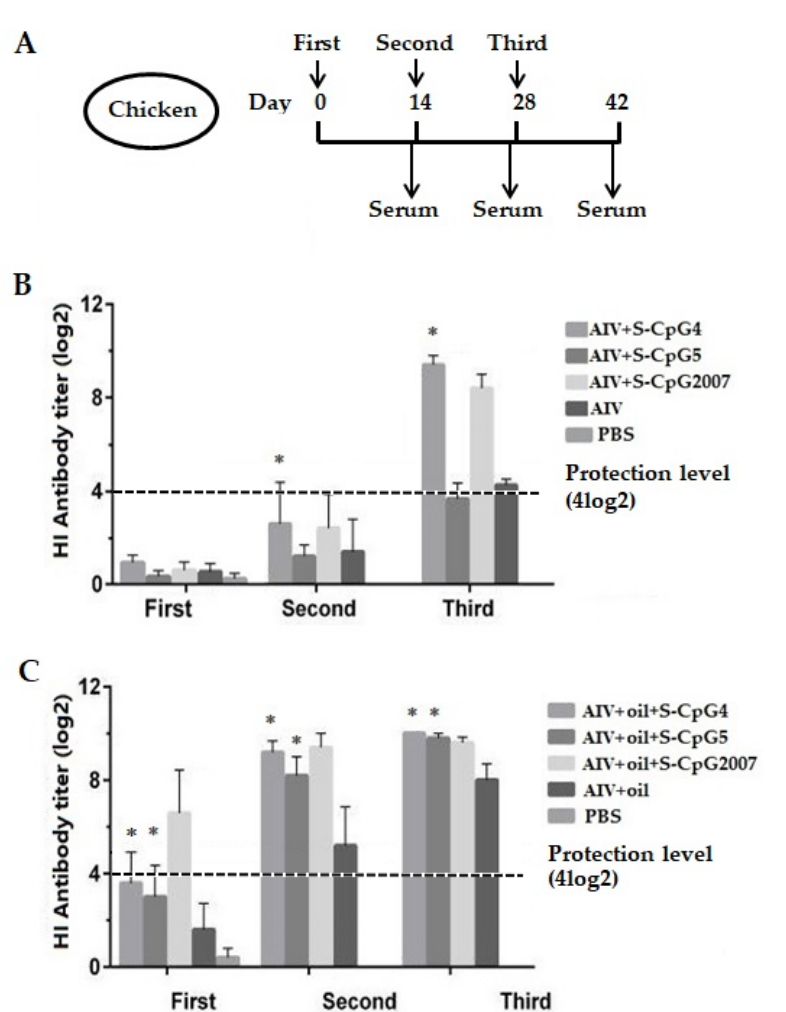
Figure 5. Antibody levels of the immunized chickens. ( A ) Scheme of immunization (n = 10/group) and samples. ( B , C ) Antigen-specific serum antibody titers of chickens with S-CpGs and AIV ( B ), and with S-CpGs and AIV and oil adjuvant ( C ) were measured with HI method. All data were presented as mean ± SD. * p < 0.05.